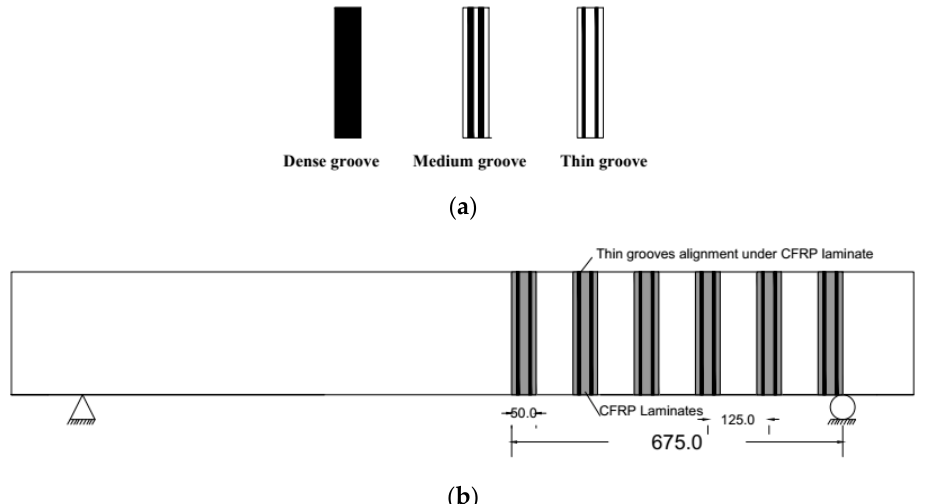
Figure 2. CFRP laminates and grooves alignment (all dimensions are in mm); ( a ) all groove types; ( b ) grooves on beam stem.